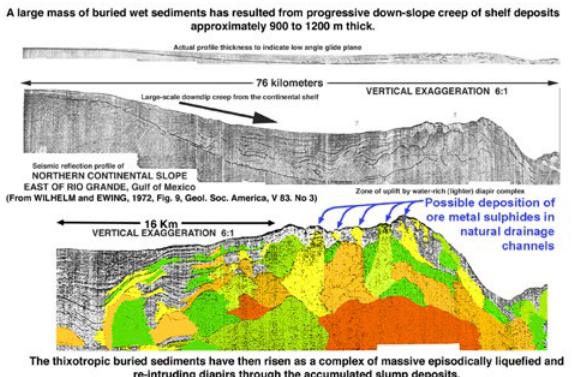
Figure 68. Many rock formations contain porphyroid complex- es and granite batholiths formed by a succession of intrusions. Synerectic porphyroids in the rocks are prospective ore source